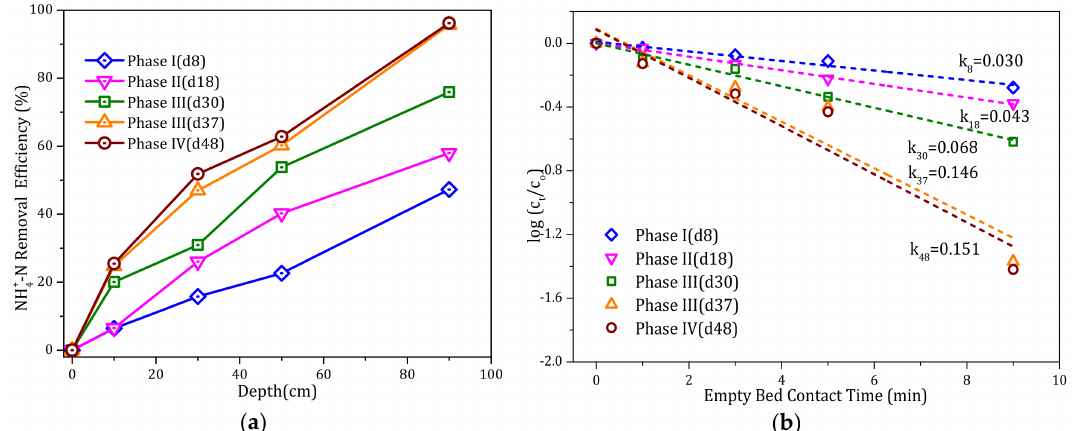
Figure 3. ( a ) Ammonium (NH 4 + ) removal e ffi ciency with filter column depth during di ff erent phases, and ( b ) linear regression analysis of NH 4 + depletion with the empty bed contact time during di ff erent phases. Day (d) and rate constant